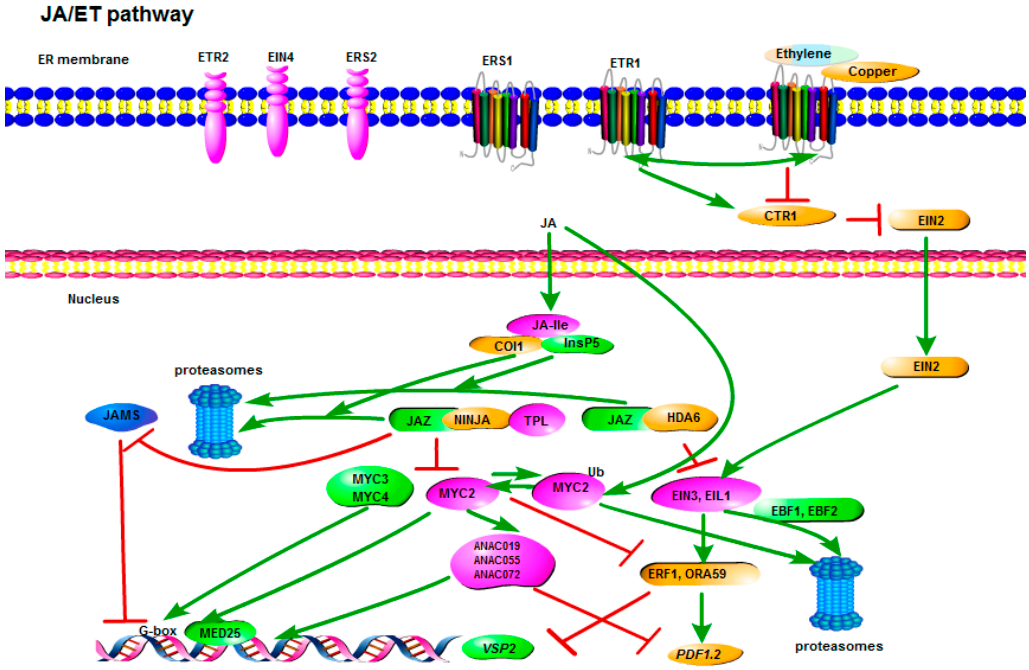
Figure 2. Model of biosynthesis and signal transduction of jasmonic acid (JA) and ethylene (ET). JA and ET can synergistically activate ethylene insensitive 3 (EIN3) and ethylene insensitive 1 (EIL1), which are positive regulators of ERF1 and octadecanoid-responsive Arabidopsis AP2 59 (ORA59), leading to the induction of plant defensin 1.2 ( PDF1.2 ). The active form jasmonoyl- L -isoleucine (JA-Ile) can be recognized by coronatine insensitive 1 (COI1) and the co-receptor Inositolpentakis phosphate 5 (InsP5), causing the degradation of jasmonate ZIMs (JAZs). There are two antagonistic branches in the JA response: the MYC branch and the ERF branch. JAZ proteins can suppress the activity of MYC2, the positive regulator of Vegetative storage protein 2 (VSP2), by enrolling the negative regulator Topless (TPL) via the novel interactor of JAZ (NINJA). MYC2 can directly interact with mediator 25 (MED25, which is a subunit of the mediator. MYC2 can activate the expression of NAC domain containing proteins (ANACs) to upregulate VSP2 . MYC3 and MYC4 can activate JA response additively with MYC2 by binding to the G-box. JAZs could also suppress the activity of jasmonate associated MYC2 like proteins (JAMs), which are a group of transcriptional repressors that could bind to the MYC2 target sequence G-box to negatively regulate the JA response. The MYC2 protein is regulated at protein levels. MYC2 can be ubiquitinated during the JA response for degradation. Thus, JA-mediated defense is suppressed. Conversely, MYC2 can be inversely deubiquitinated to stay stable, triggering a positive regulation on JA response. In the ERF branch, JAZs can inhibit the activity of EIN3 and EIN3-like 1 (EIL1) by direct association with them and enrollment of the histone deacetylase 6 (HDA6). In the ET pathway, there are five ethylene receptors localized in the ER membrane. A copper ion interacts with the ethylene-binding domain. The interaction is required for high-affinity ethylene-binding activity. By binding to ET, constitutive triple response 1 (CTR1) is deactivated by ET receptors. CTR1 can inhibit EIN2, which activates EIN3 and EIL1 by preventing their degradation of them via EIN3-binding F box protein 1 and 2 (EBF1 and EBF2). Activation (closed arrowhead), suppression ( ⊥ ), and important genes are indicated.